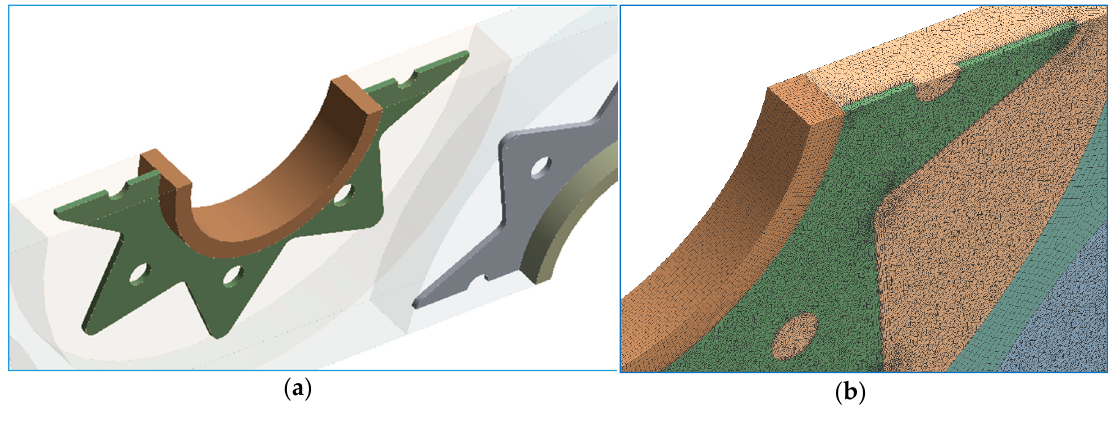
Figure 3. 3D view of fins ( a ) and the mesh detail ( b ).